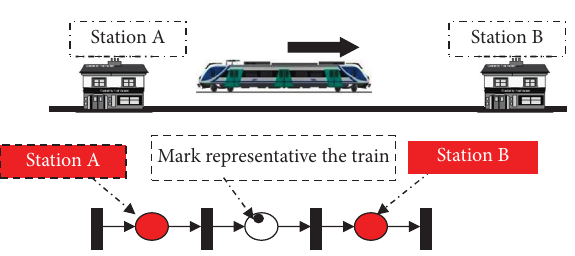
Figure 4: The Sahel railway line.